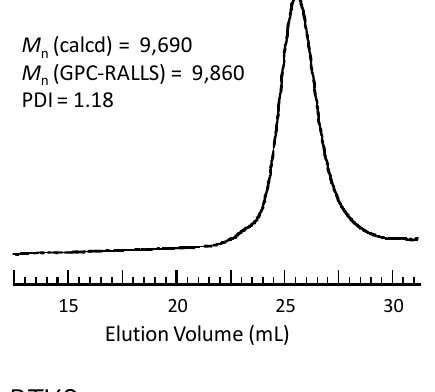
Figure 1. SEC RI trace of PTVS homopolymer.